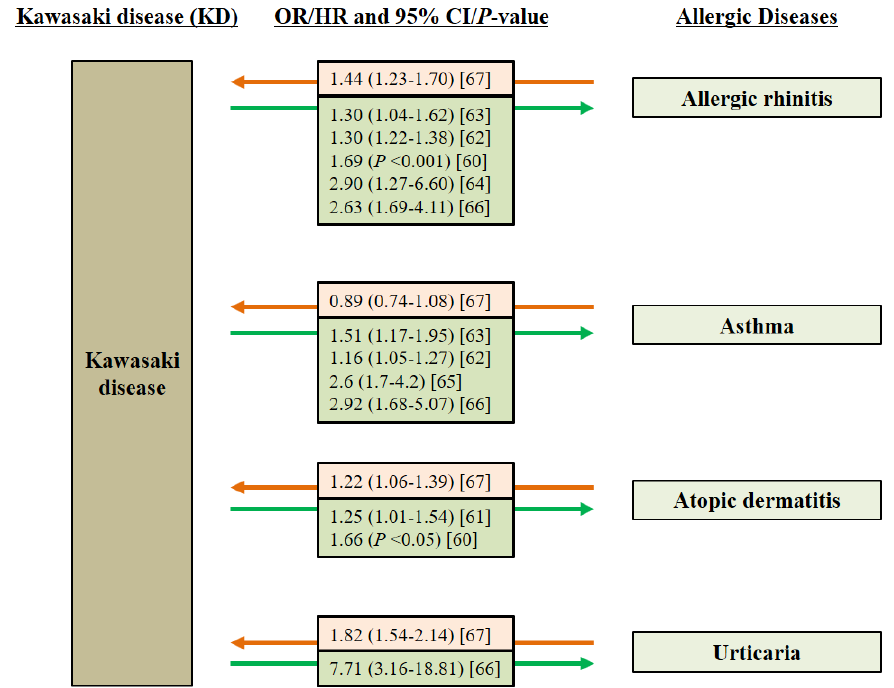
Figure 3. Increased risk of Kawasaki disease (KD) in children with common allergic diseases and vice versa. CI, confidence interval; HR, hazard ratio; OR, odds